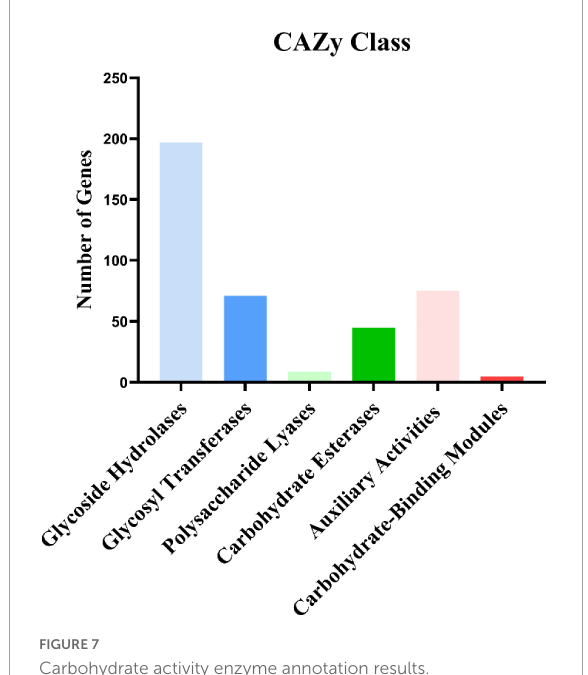
molecular functions, we selected the top 20 annotations under each classification. The most abundant secondary classification of GOslim was drawn, and it was found that the “cell division” has the highest gene enrichment in the biological process,